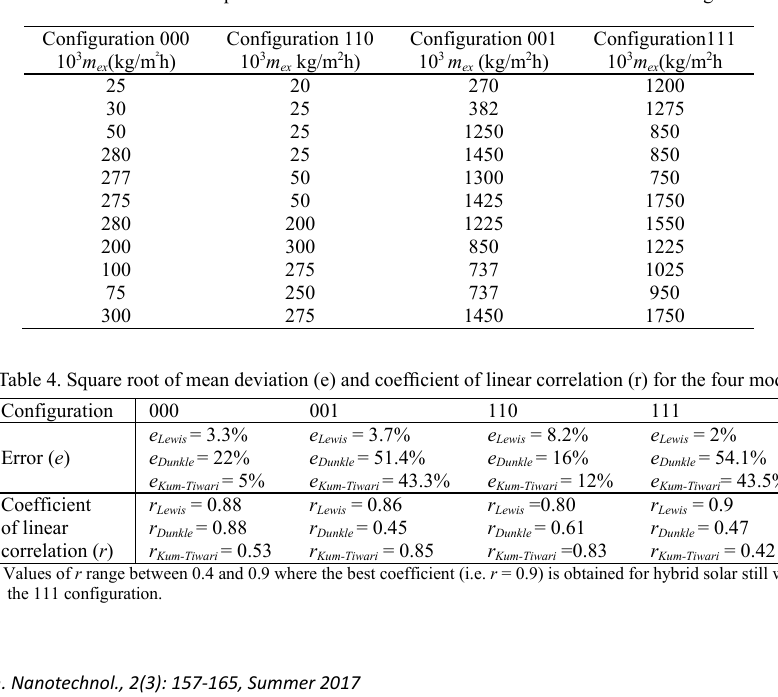
Table 3. The obtained experimental distilled mass flow rate for the four studied configurations